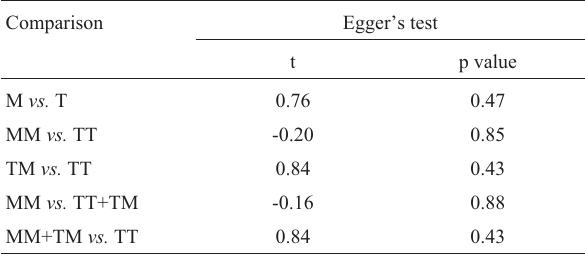
Table4 -Testsforpublicationbias(Egger’stest)inpopulation(overall).